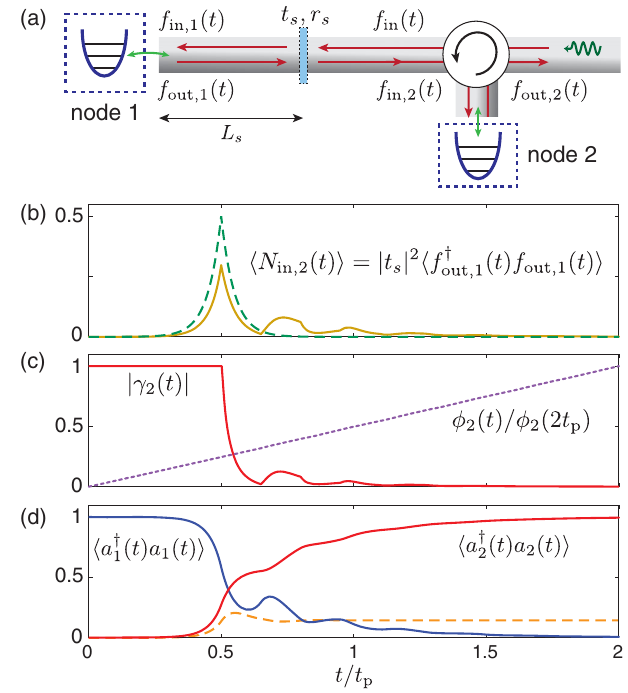
FIG. 5. (a) The coherent backscattering of fields by defects or imperfect connections is modeled by a pointlike scatterer with 2 ¼ 1 − j t 2 , located at a distance L reflectance j r from the first s j s j s node. (b) Shape of the emitted wave packet (solid line) measured after the scatterer at the input of node 2. For this plot, γ 1 ð t Þ is the 2 L 0 . 15 t 20 γ − 1 , =v same as in Fig. 3(a), τ , t ffiffiffiffiffiffiffiffiffiffiffiffi p s ¼ s g ¼ p p ¼ 1 − t 2 r ¼ 0 . 6 , and a detuning δ ¼ ω 1 − ω 2 ¼ γ between s s ¼ the two local oscillators has been assumed. The green dashed line 0 . (c) Shape of the shows the unperturbed wave packet for r s ¼ recovery pulse γ 2 ð t Þ ¼ j γ 2 ð t Þj e − i 2 ϕ 2 ð t Þ with a final phase ϕ 2 t ≃ 2 . 03 × δ t obtained from a numerical optimization 2 ð p Þ p of the state transfer problem. (d) Plot of the resulting evolution of 1 i . the population of each oscillator for an initial state j ψ q i ¼ j The dashed line shows the population in the second oscillator for the original pulse γ 2 ð t Þ given in Fig.